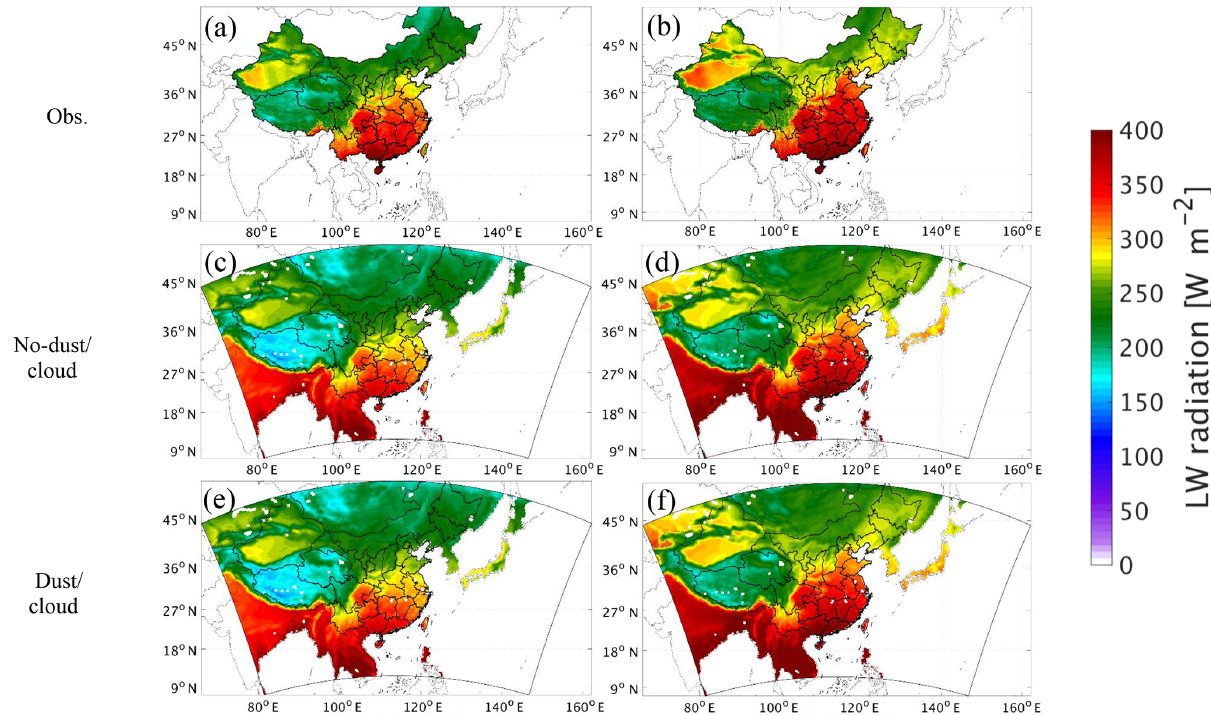
Figure 2. Spatial distributions of the average downward LW radiation at the surface from observations (a, b) , from NO-DUST/CLOUD (c, d) , and from DUST-CLOUD (e, f) during March (left panels) and April (right panels) 2012.